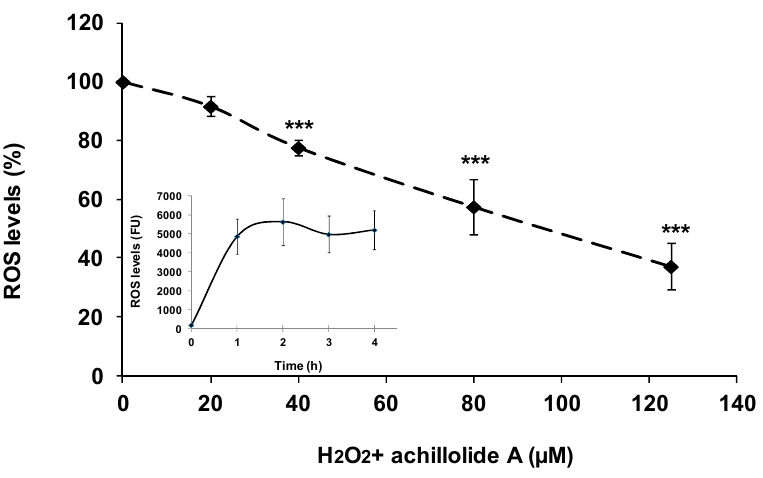
Figure 4. Achillolide A attenuates H 2 O 2 -induced ROS levels in astrocytes. Astrocytes were preloaded with DCF-DA for 30 min and washed. Preloaded astrocytes were then preincubated for 2 h with various concentrations of achillolide A. H 2 O 2 (175 μ M) was added to the culture and the fluorescence intensity representing ROS levels was measured 1 h later. The results represent means ± SEM of two separate experiments ( n = 8). *** p < 0.001. Insert: ROS levels of cells that were treated with 175 μ M H 2 O 2 were measured at the indicated time points.